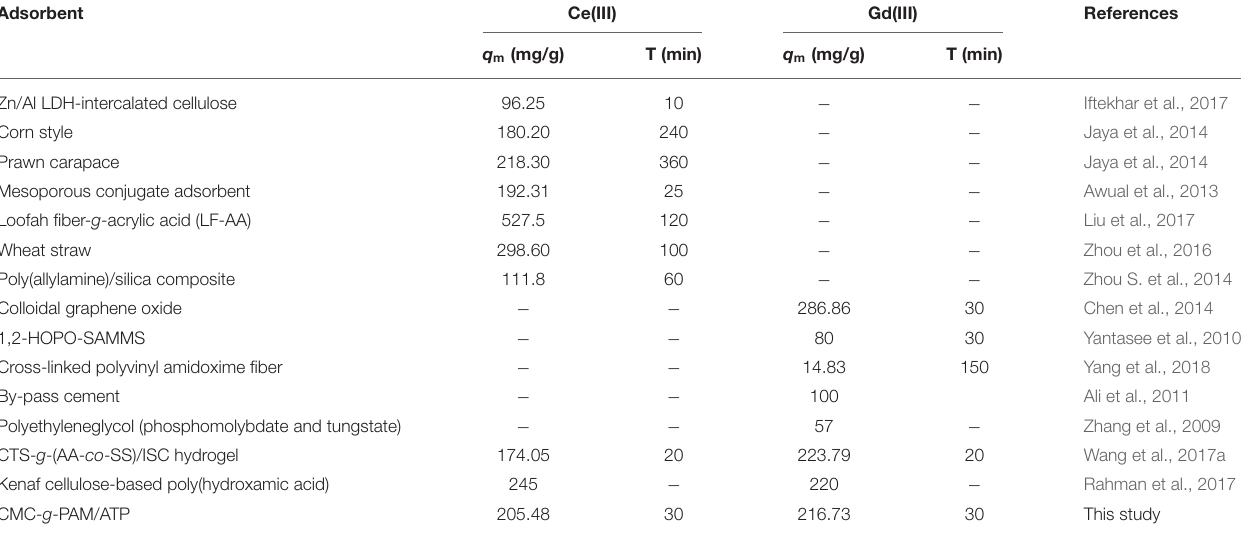
TABLE 4 | Comparison of adsorption capacities ( q m , mg/g) and rates (T, min) of various adsorbents for Ce(III) and